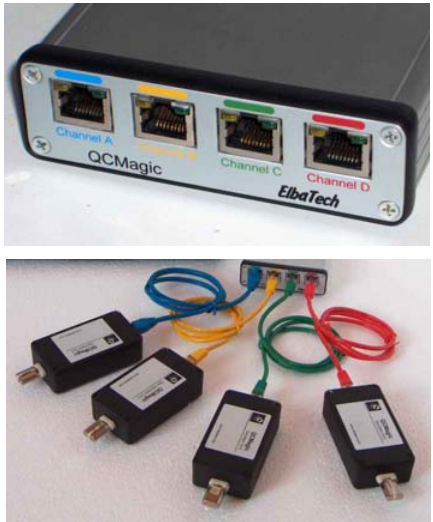
Figure 2. Nanogravimetric base-unit, able to drive up to four oscillating units ( Upper ). Oscillators unit connected via Ethernet cable to the base unit ( Lower